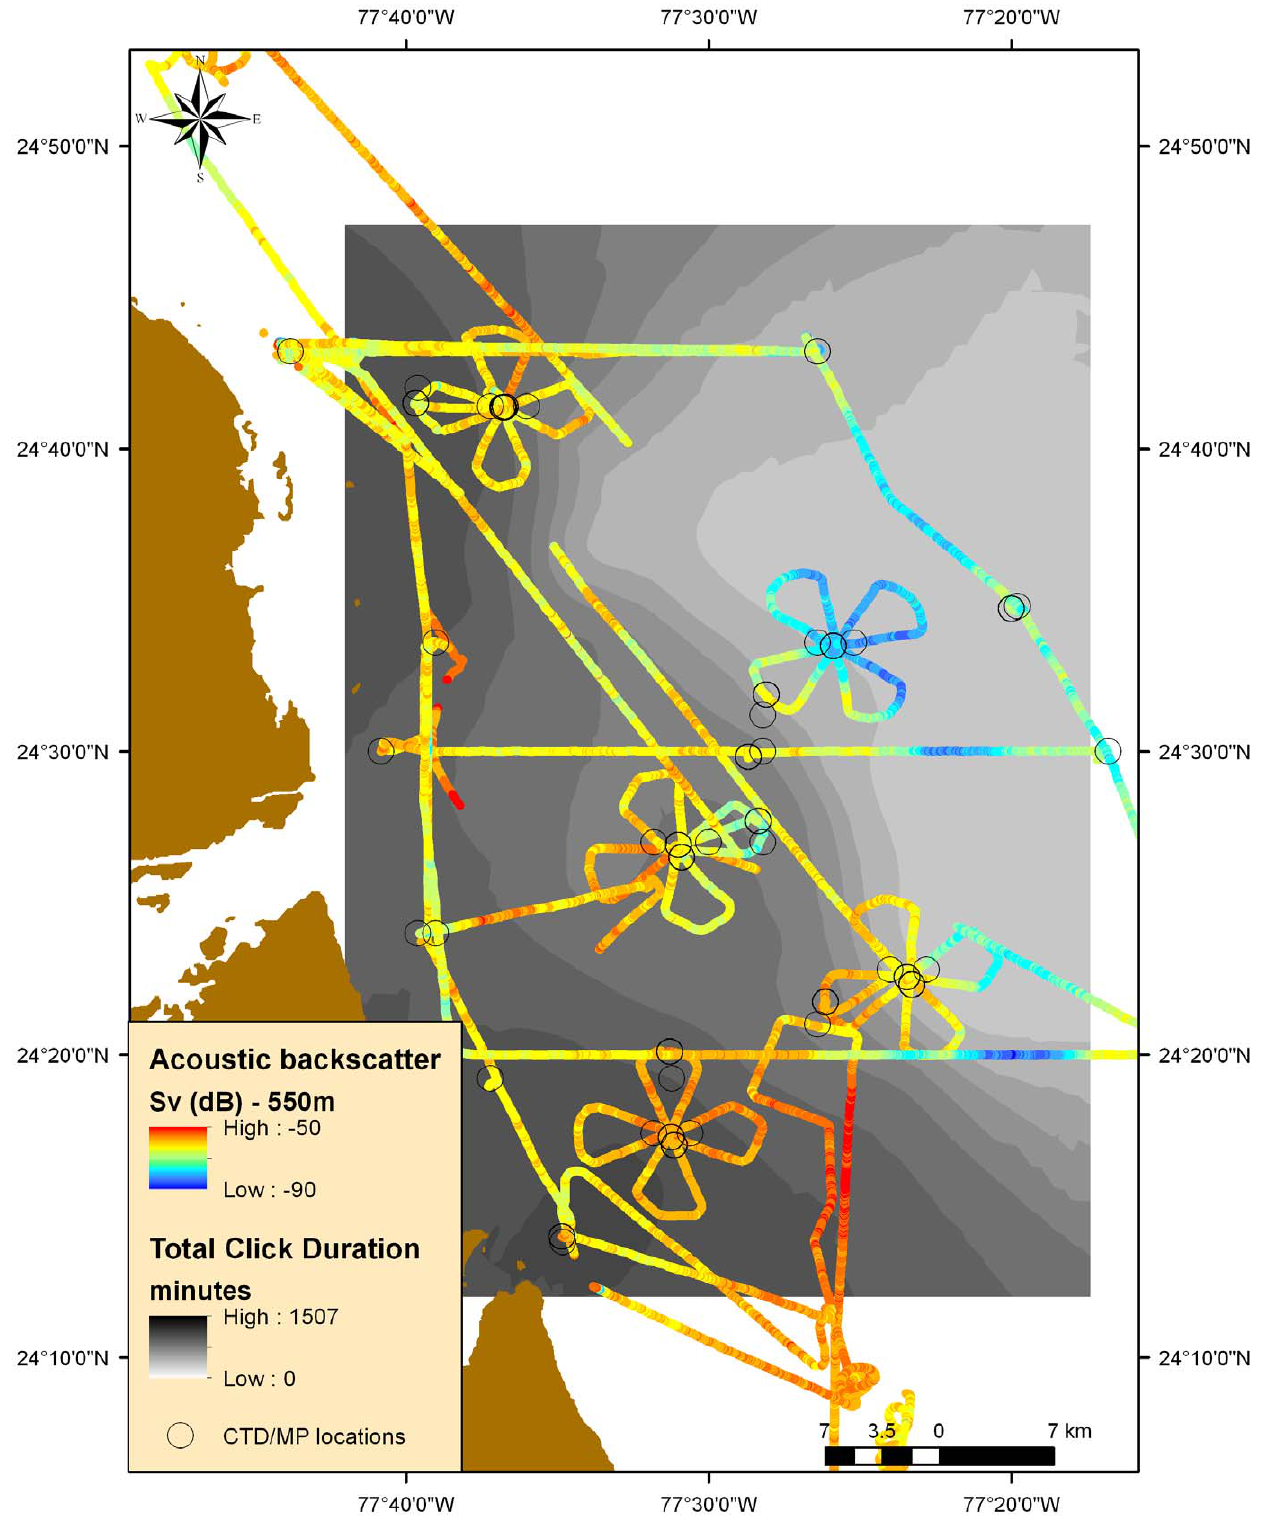
Figure 5. This plot shows interpolated relative foraging density at the extent of the hydrophone arrays in light to dark grey and backscatter at 550 meters from blue to red points representing low to high values. Circles are locations of CTD and MP casts. The western and southwestern areas of the study area had higher foraging effort and greater mean scattering volume.